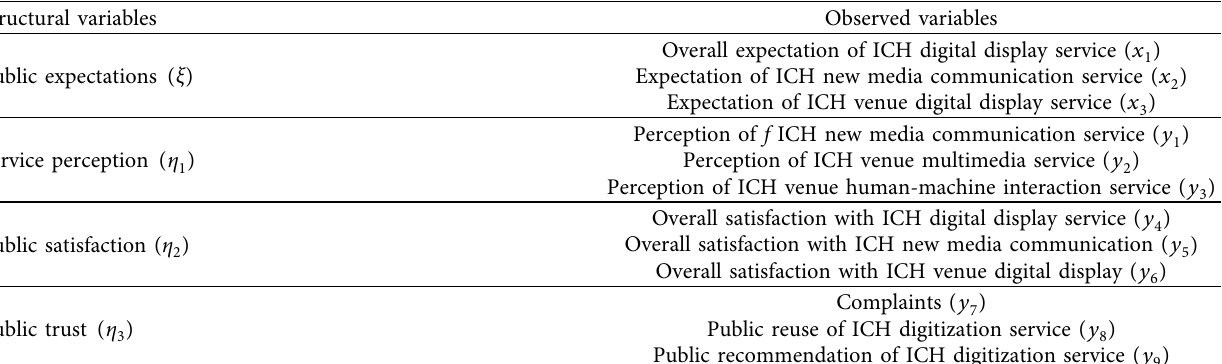
Table 1: Measurement